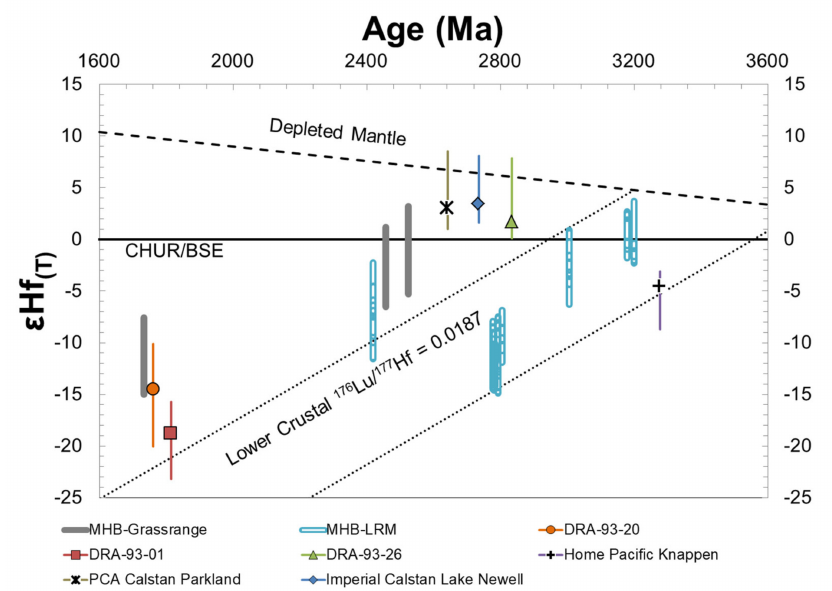
Figure 6. Lu-Hf evolution diagram showing the range for the drill core and xenolith samples. Lu-Hf data from xenoliths from the Medicine Hat block (MHB) are shown for comparison (thick gray bars; [56]). Lu-Hf data from the Little Rocky Mountains are shown for comparison (open bars; [57]). Evolution path based on lower crustal Lu / Hf ratios from Rudnick and Gao [90] (dotted lines). Symbols represent error-weighted means. CHUR: Chondritic Uniform Reservoir; BSE: Bulk Silicate